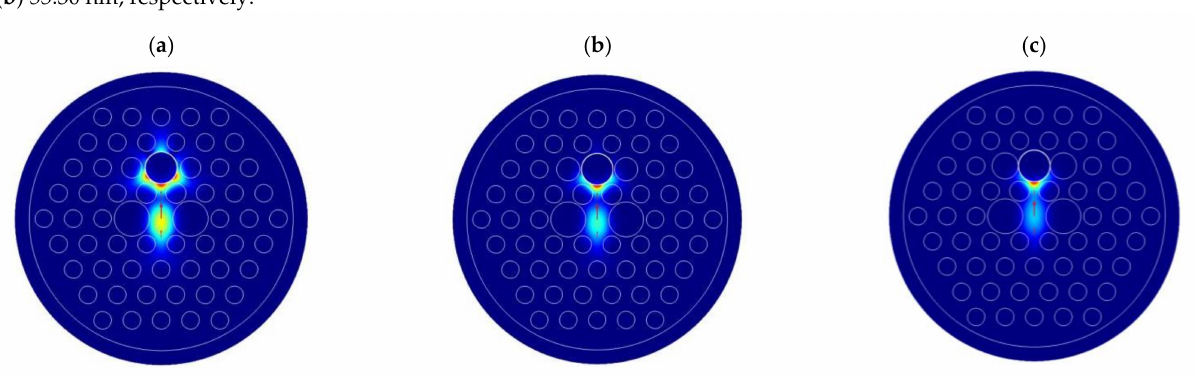
Figure 2. Loss and the real part of effective refractive index (Re( n eff )) of CM and SPM as t is ( a ) 25.60 nm and ( b ) 55.30 nm, respectively.